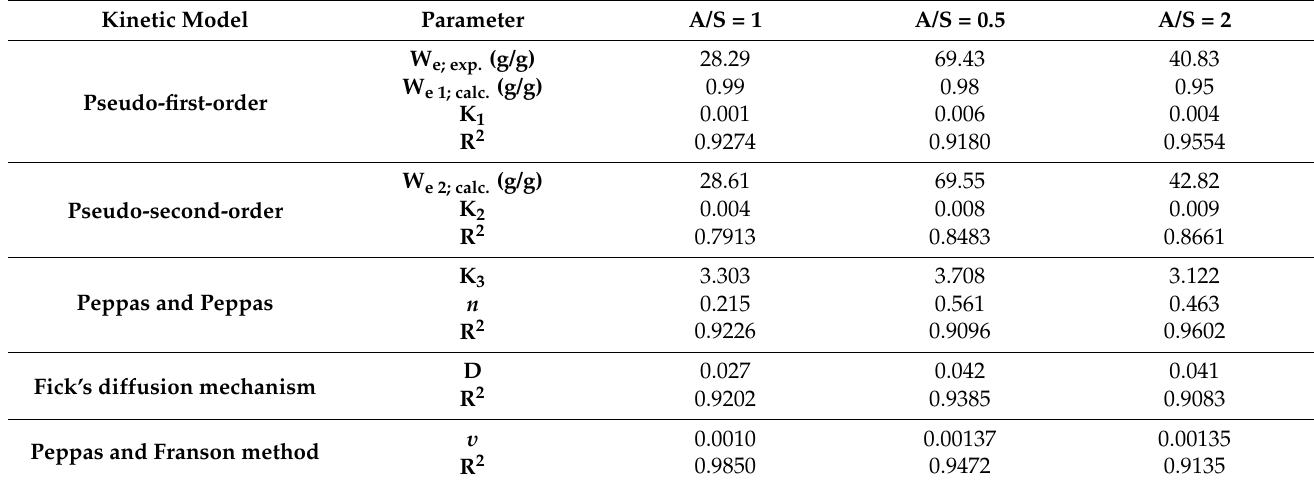
Table 3. Experimental swelling (We, exp. (g/g)) and model swelling (% We 1, calc. (g/g); We 2,